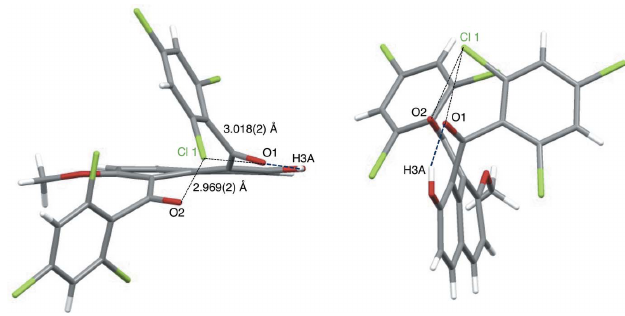
Figure 1 The molecular structure of the title compound, with atom labelling. Displacement ellipsoids are drawn at the 50% probability